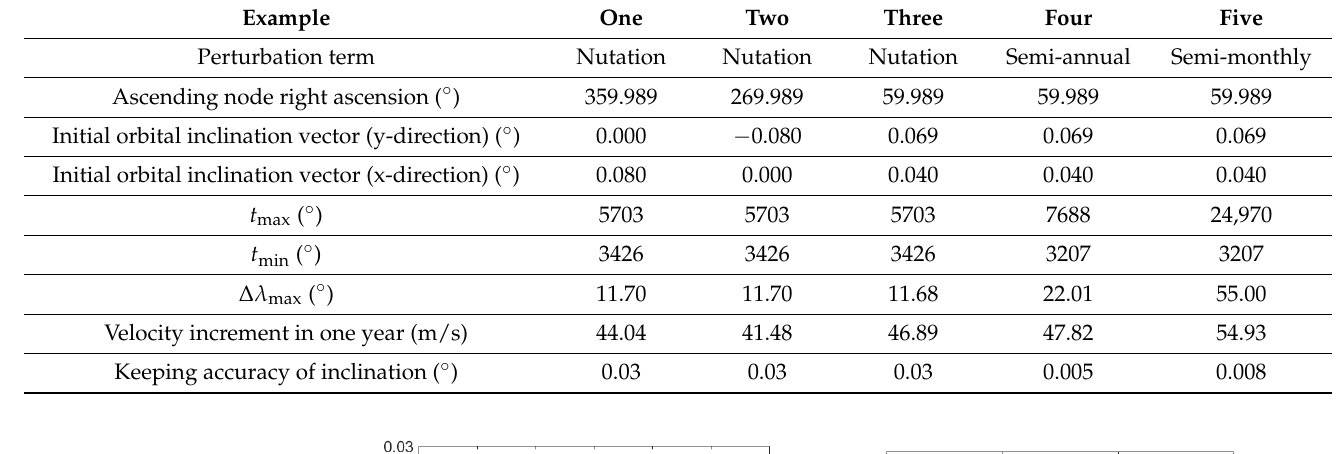
Table 3. Summary of Simulation.